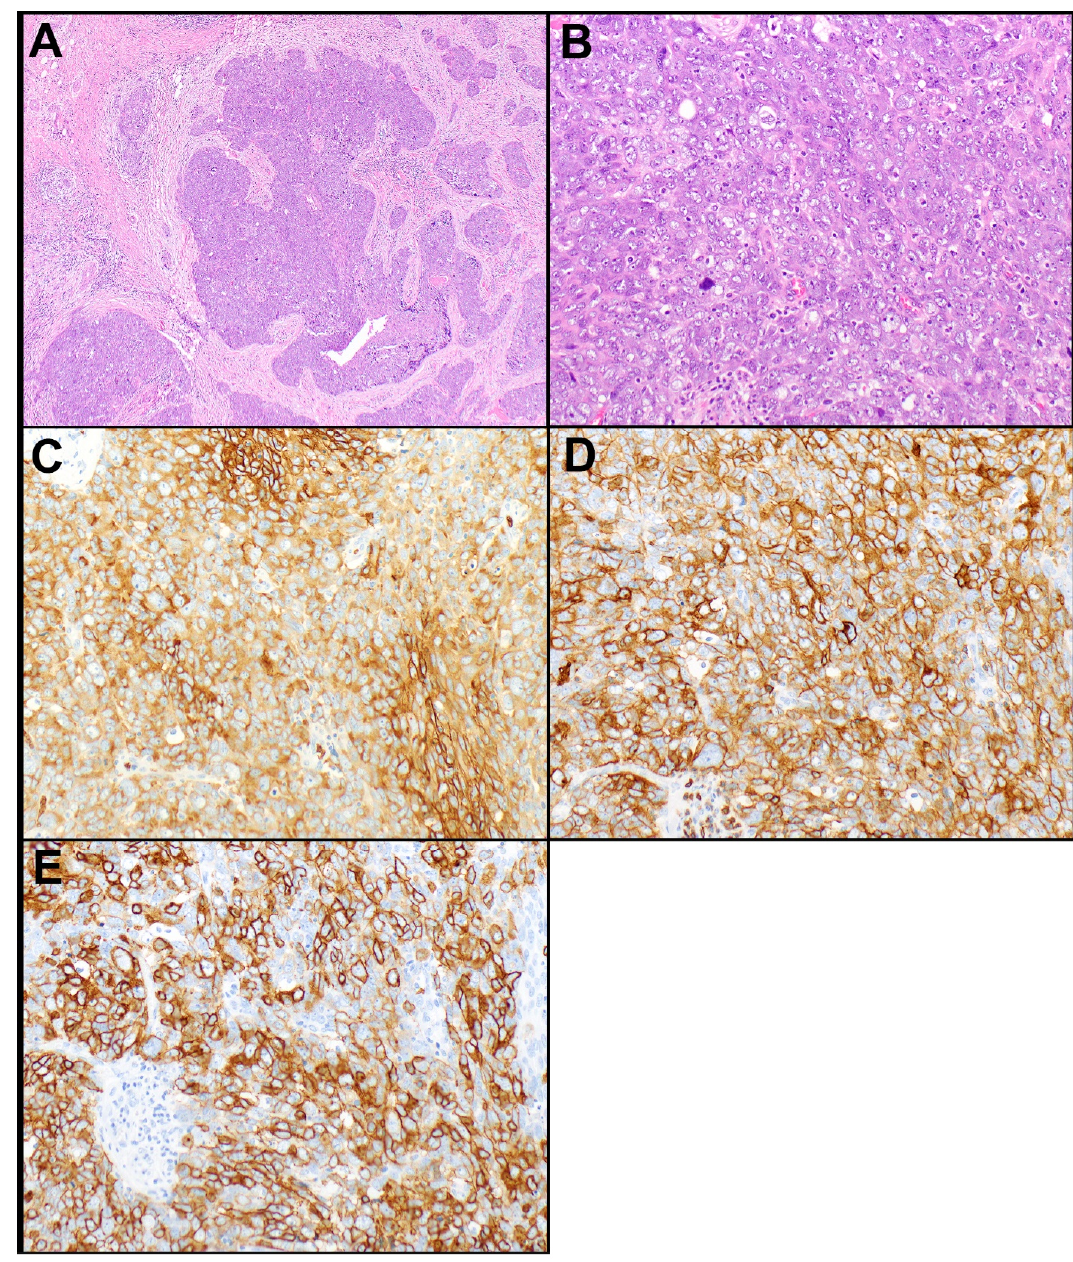
Figure 2. Thymic squamous cell carcinoma. ( A ) Irregular nests of tumor cells are growing in a desmoplastic stroma. ( B ) The tumor cells exhibit increased cytologic atypia with slight nuclear pleomorphism, vesicular nuclear chromatin, and conspicuous nucleoli. ( C ) The tumor cells express diffusely GLUT1 (90% of tumor cell expression, membranous; C ), CD 5 (100% of tumor cell expression; D ), and CD117 (90% of tumor cell expression; E ). Magnification, H&E ×40 ( A ), ×200 ( B ), GLUT1 ×200 ( C ), CD5 ×200 ( D ), CD117 ×200 ( E ).